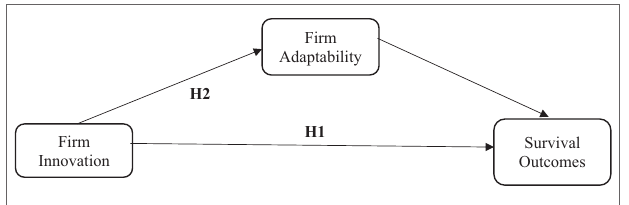
FIGURE 1 | The hypothesized